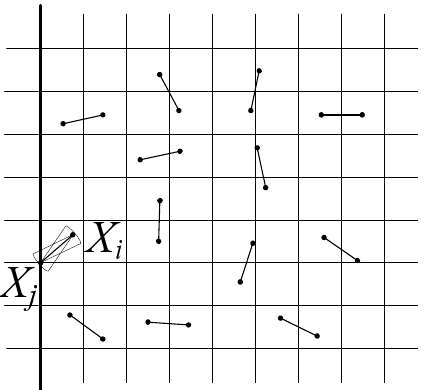
Figure 4. The plane is divided into two